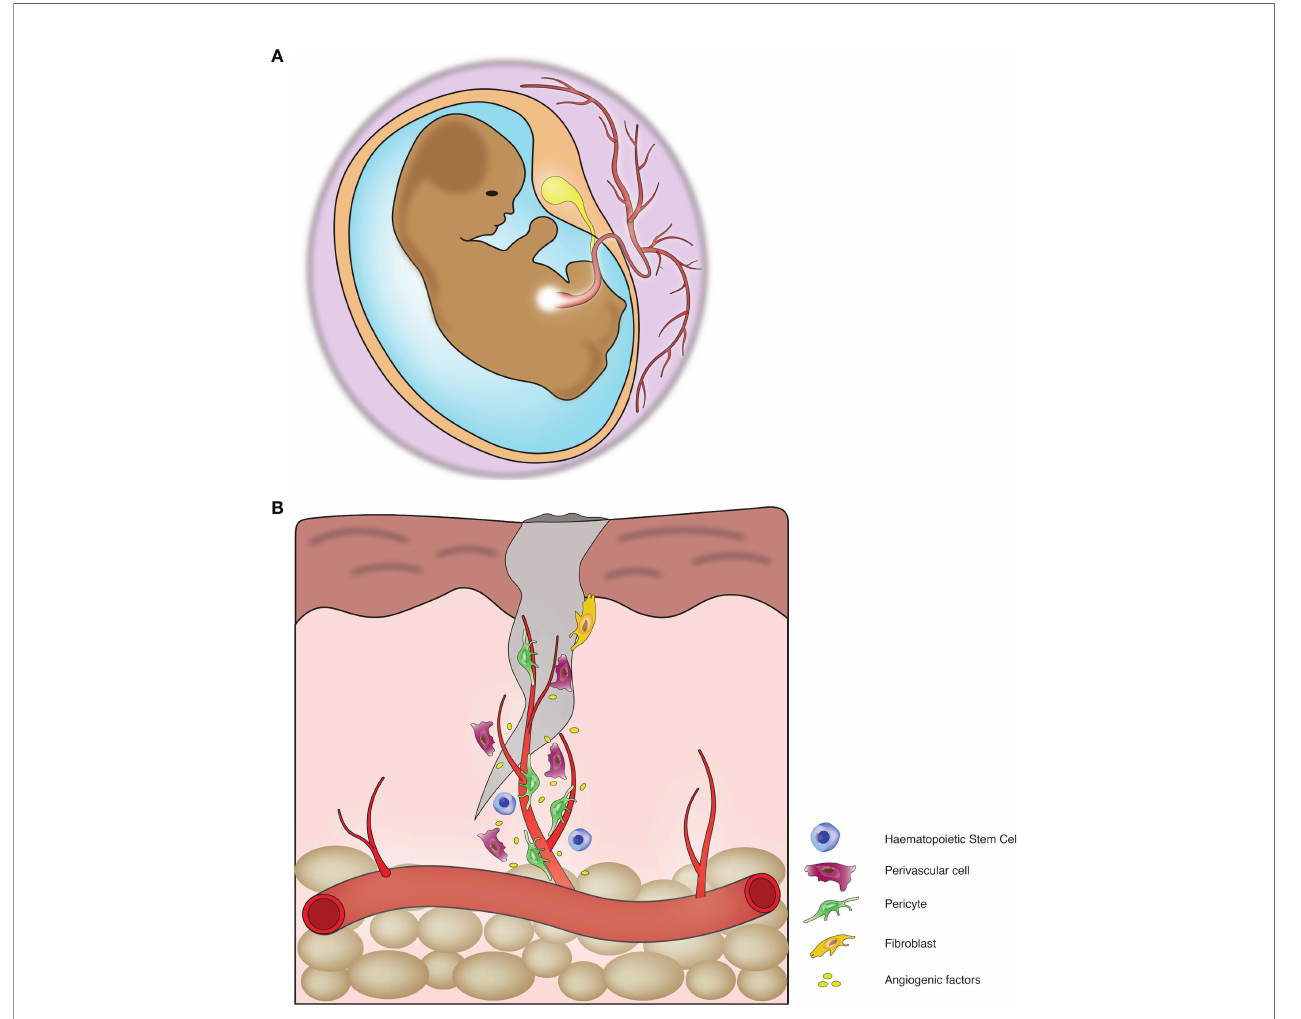
FIGURE 1 | Blood vessels mediate tissue development and regeneration: (A) Blood vessels play crucial roles during organogenesis. (B) Blood vessels play a critical role in tissue repair and